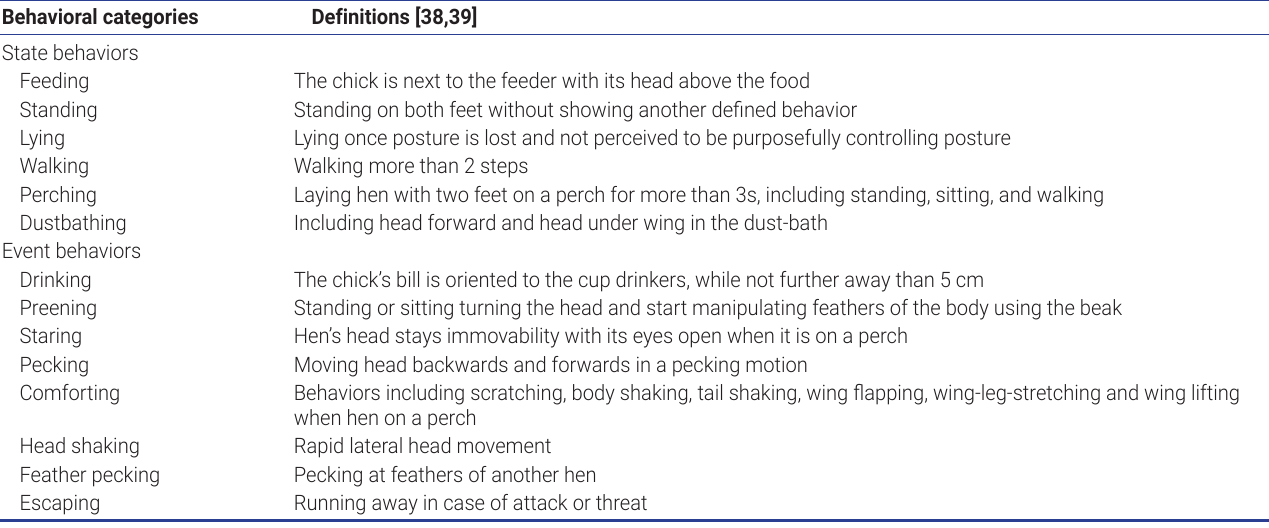
Table 4. Definitions of general